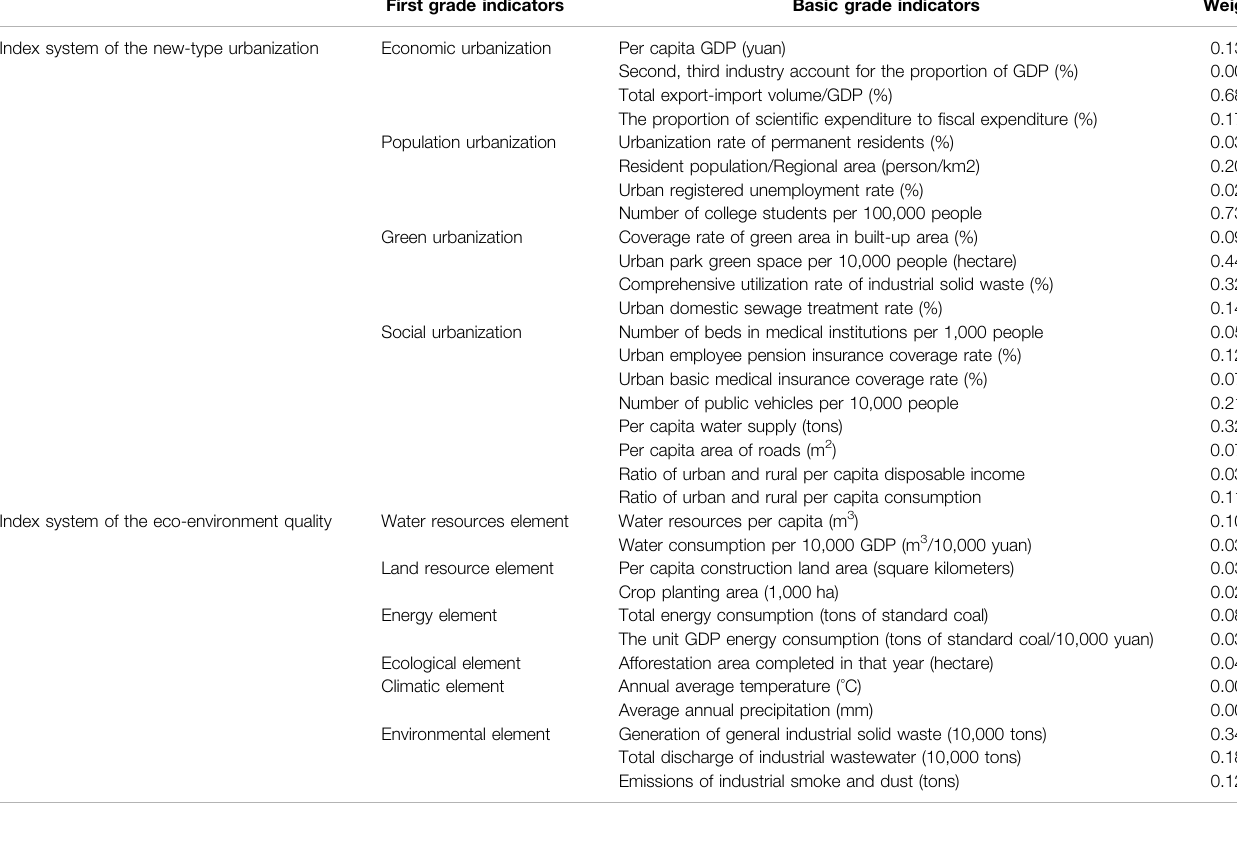
TABLE 1 | The evaluation indicators system of new-type urbanization and eco-environment quality.